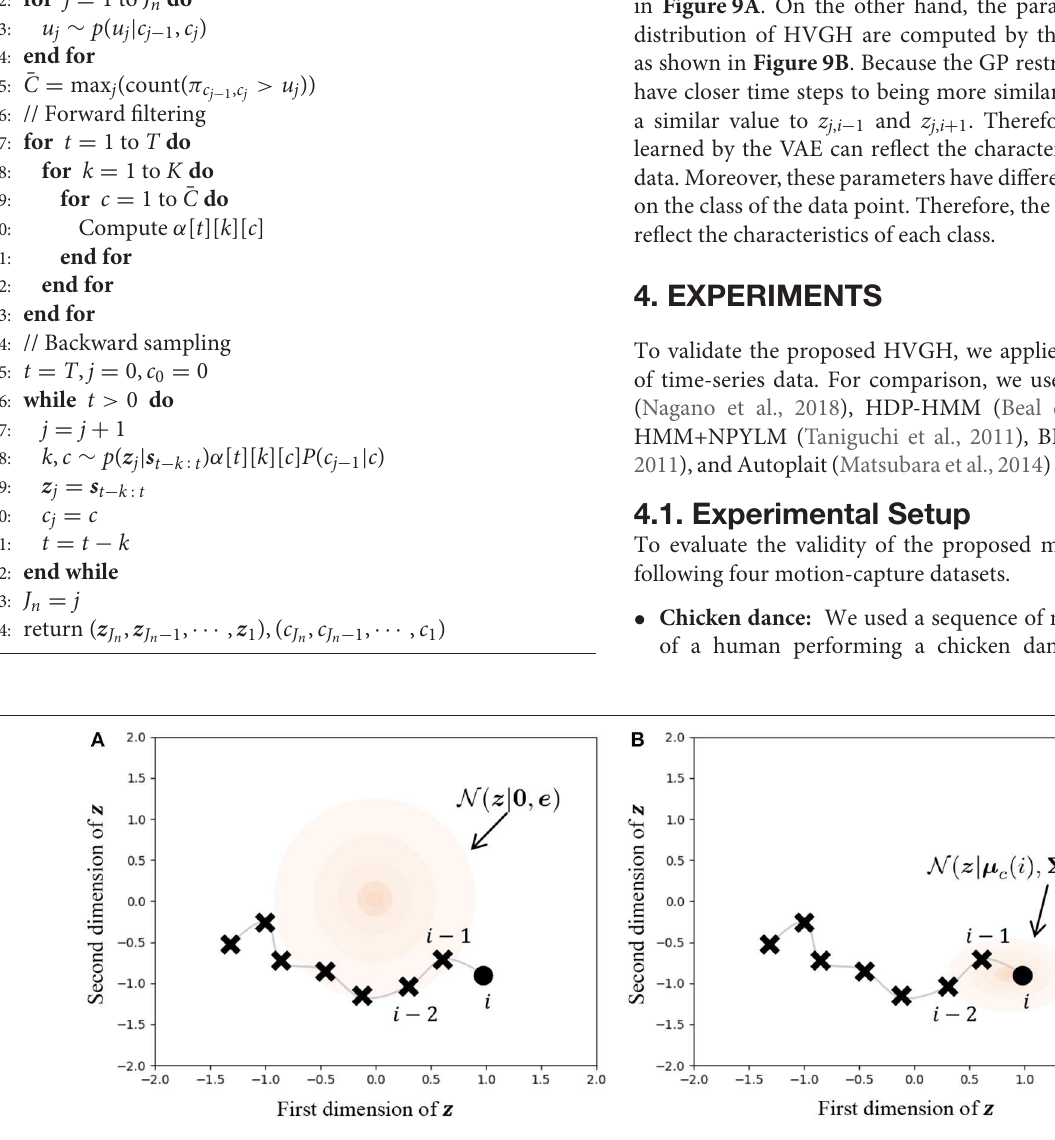
FIGURE 9 | Influence of prior distribution. The orange region represents the standard deviation. (A) The same prior distribution is used for any data points in the normal VAE. (B) The distribution is varied depending on the time step and the class of the data point in the VAE in HVGH.